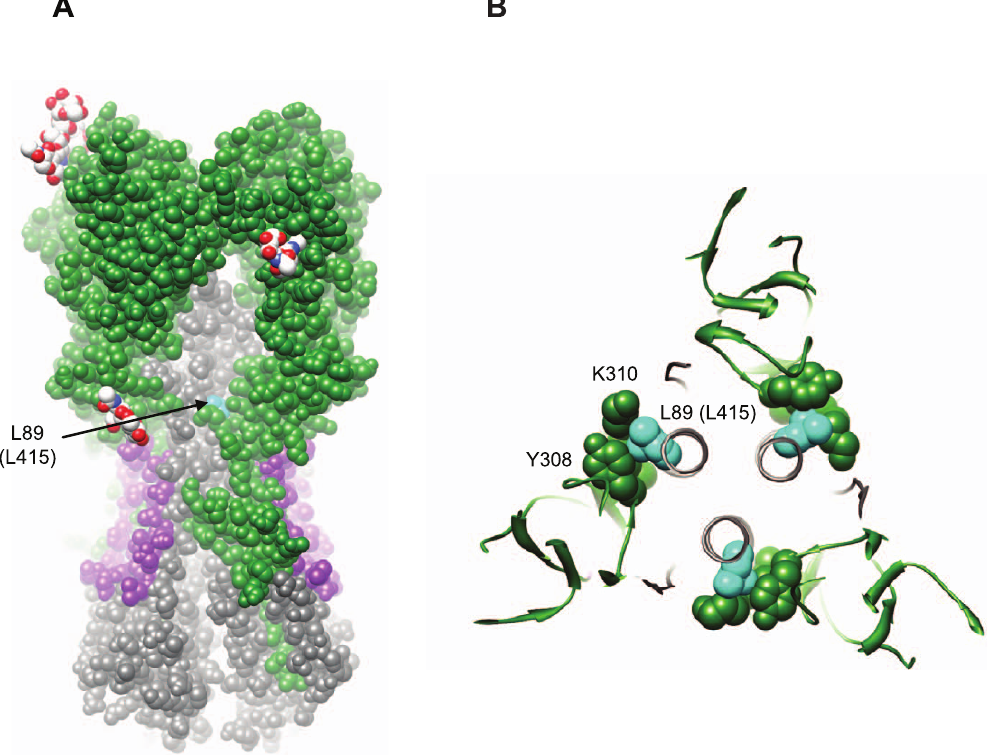
Figure 7. Structural implications for the L89I (L415I) mutation in HA2. (A) Space filling representation of the surface of A/California/04/2009 HA (PDB:3LZG) to show the recessed location of L89 (L415) (cyan). HA1 is colored green; HA2 is colored gray; the HA2 stem epitope structurally defined in Sui et al. [18] and Ekiert et al. [17] is colored purple; and glycans at glycosylation sites are colored by heteroatom (carbon white, oxygen red, and nitrogen blue). (B) Depiction of the packing interaction between L89 (L415) and residues in an adjacent loop in HA1 (PDB:3LZG). Molecular graphics images were produced using the UCSF Chimera package (supported by NIH P41 RR001081) [45].